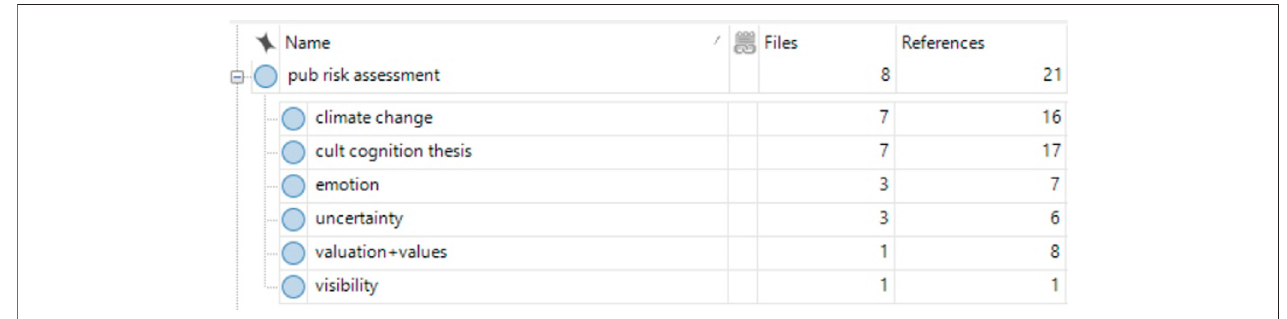
FIGURE 2 | Screenshot of NVivo 12 showing coded articles related to public risk assessment. Public risk assessment is the fi rst tier category, and those listed below it were the codes identi fi ed as existing within the larger category.